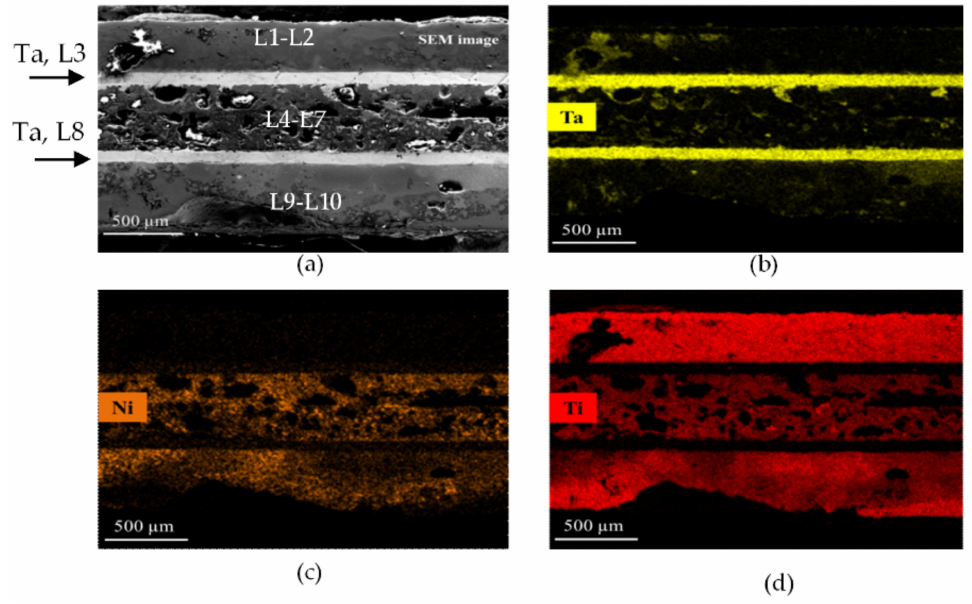
Figure 4. SEM image ( a ) and EDX-mapping ( b – d ) for the cross-section of the layered composite (layers indicated to the left, see Table 2) derived from Set 1